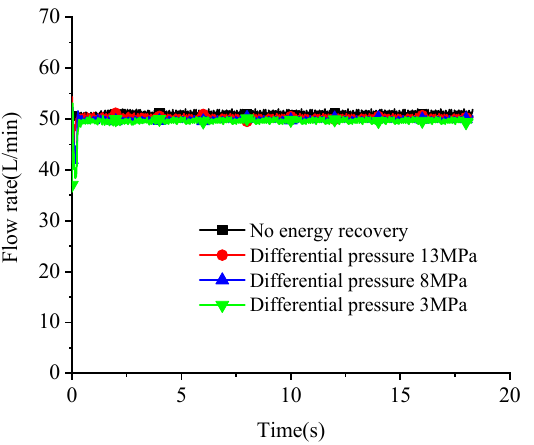
Figure 28. The input flow of the relief valve under different pressure difference control.